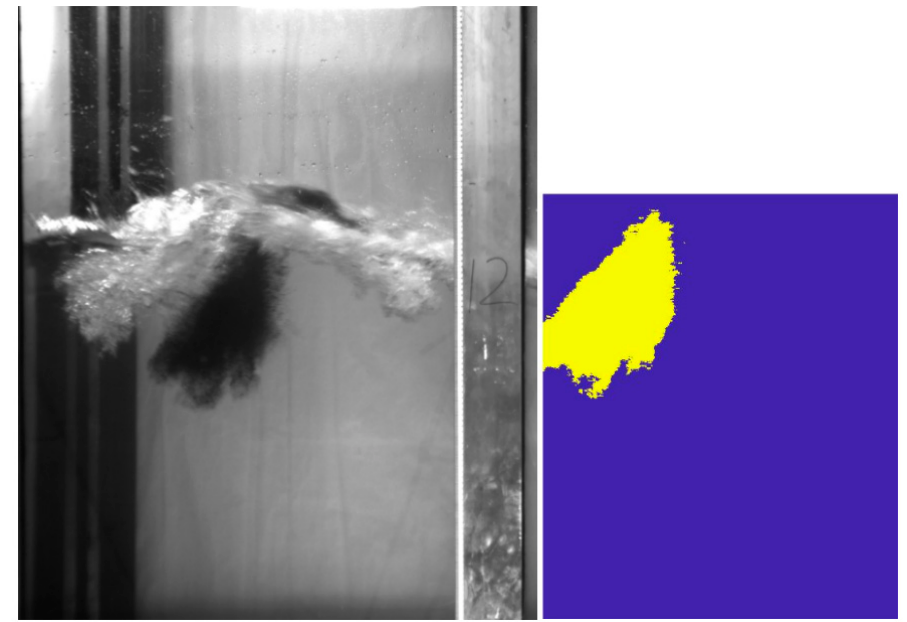
Figure 9. Spilled oil in the observation area was hit by 25 cm breaking wave.